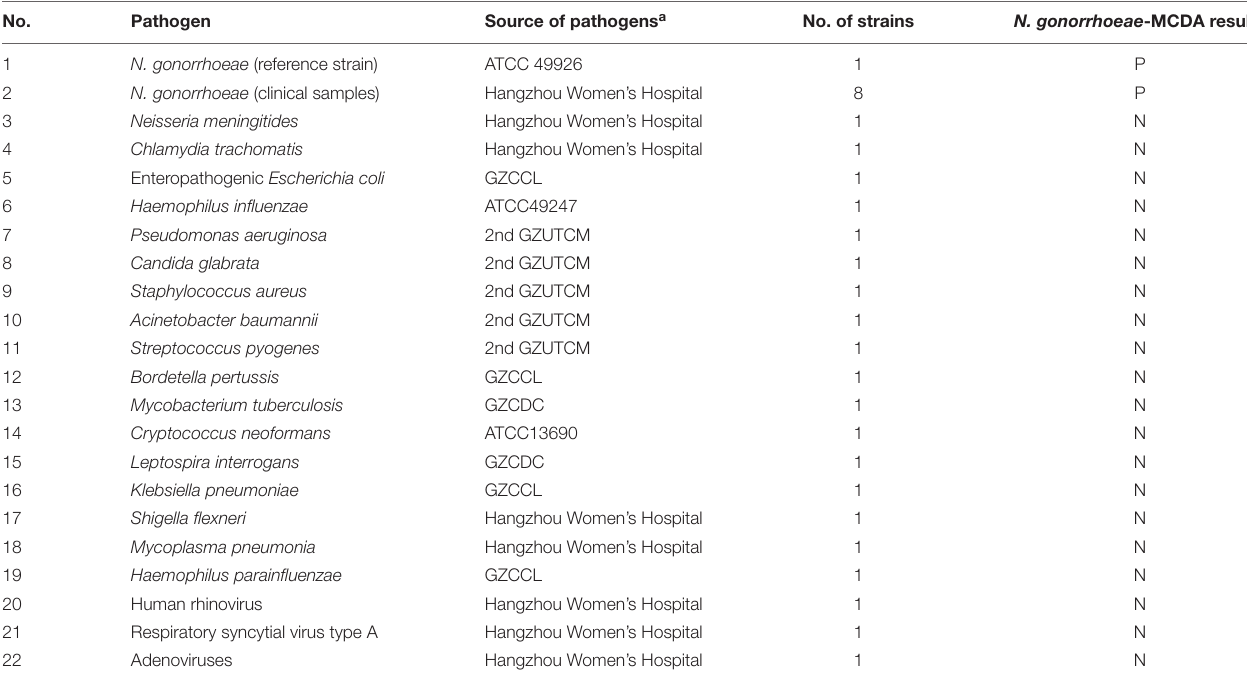
TABLE 2 | Pathogens used in this